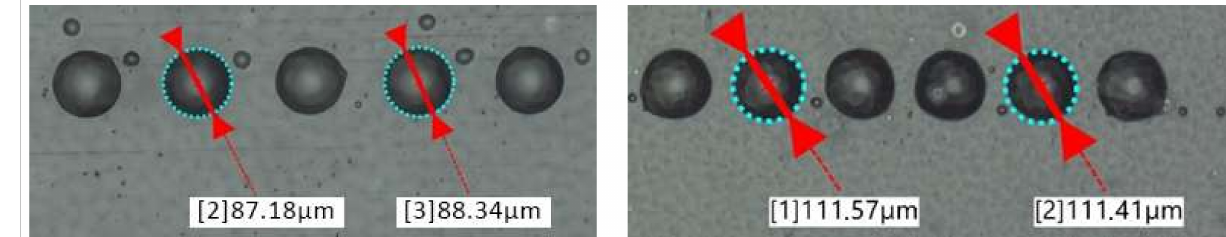
Figure 14. Characterization of droplets laying on the substrate.